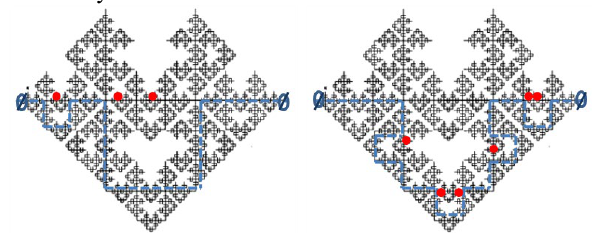
Figure 5. Current flow path at various positions of blocked adsorption centers